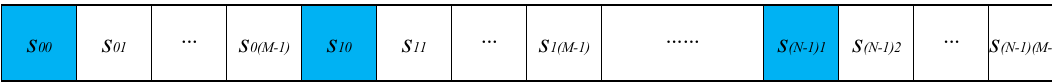
Figure 3. The data of the same group of IFFT.